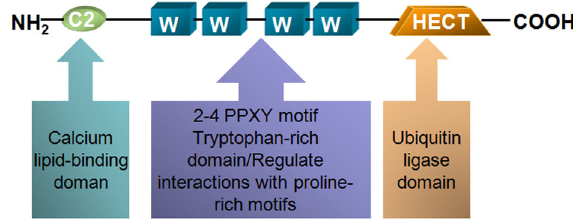
Fig. 1 The chemical constitution of WWP1. Table 1. Expression and prognosis values of WWP1 in human